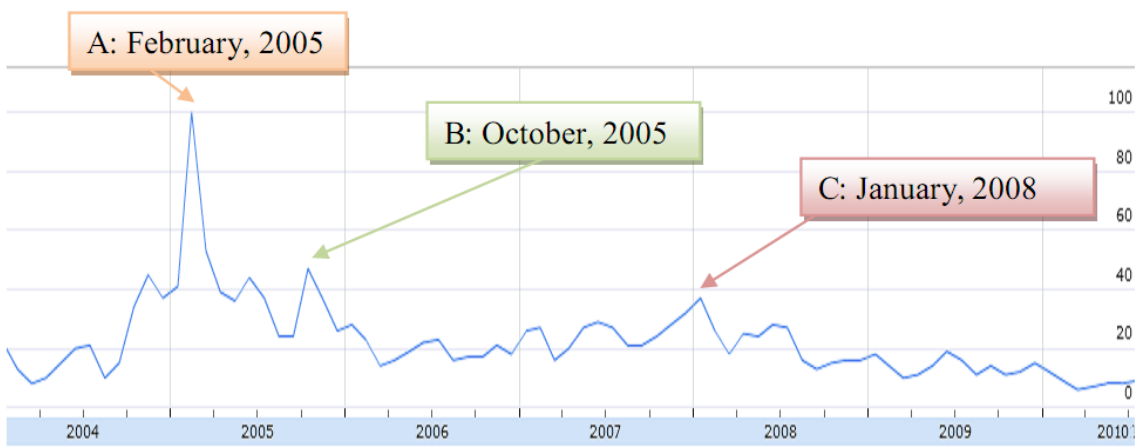
Figure 2. Index of interest shown in search term “Kyotogiteisho” ( Graph generated by Google Insights for Search on 19 July 2010